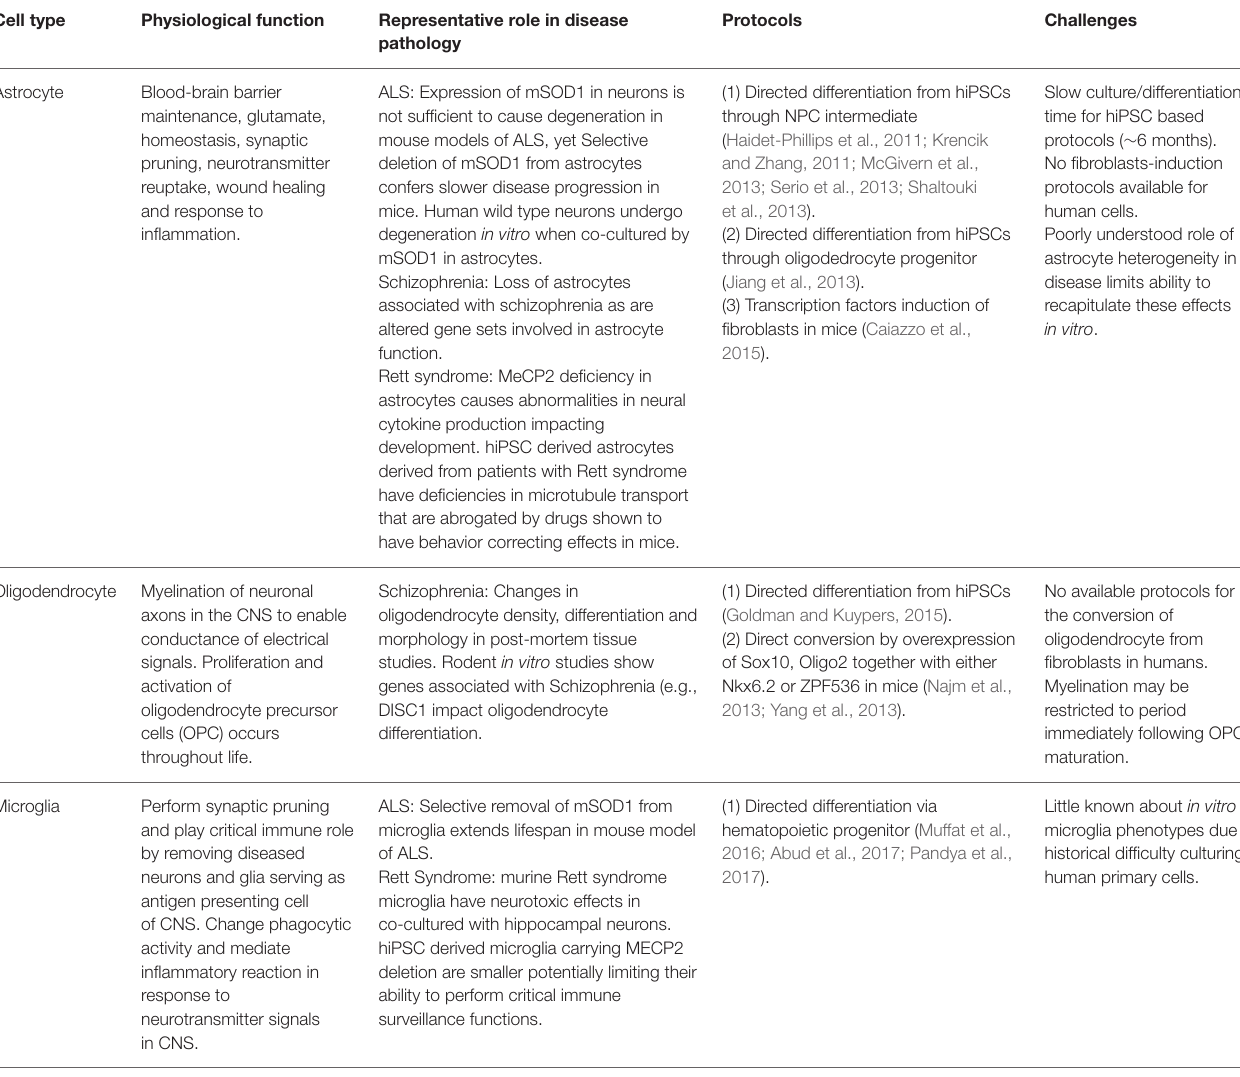
TABLE 1 | Contribution of non-neuron cell types in neurodegenerative and neuropsychiatric diseases. Cell